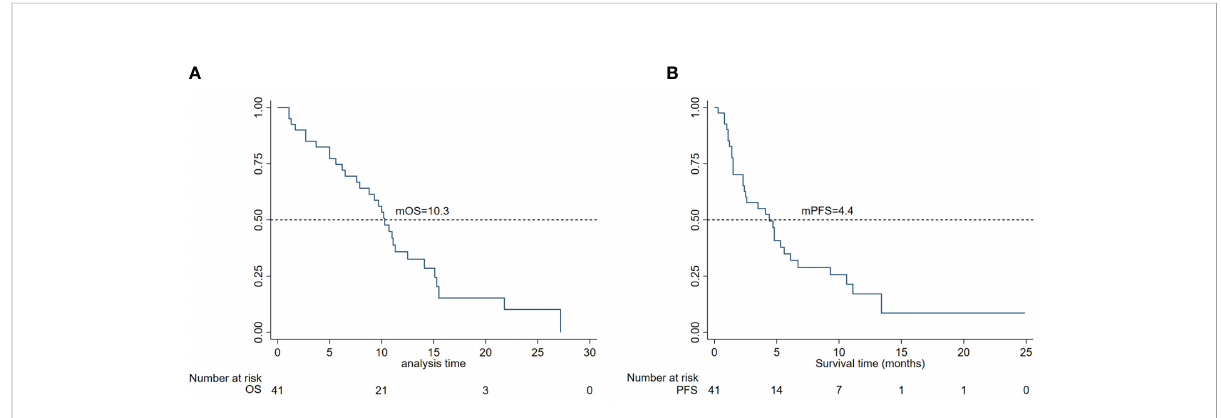
FIGURE 2 (A) Kaplan – Meier curves for overall survival and (B) progression-free survival in 45 patients.